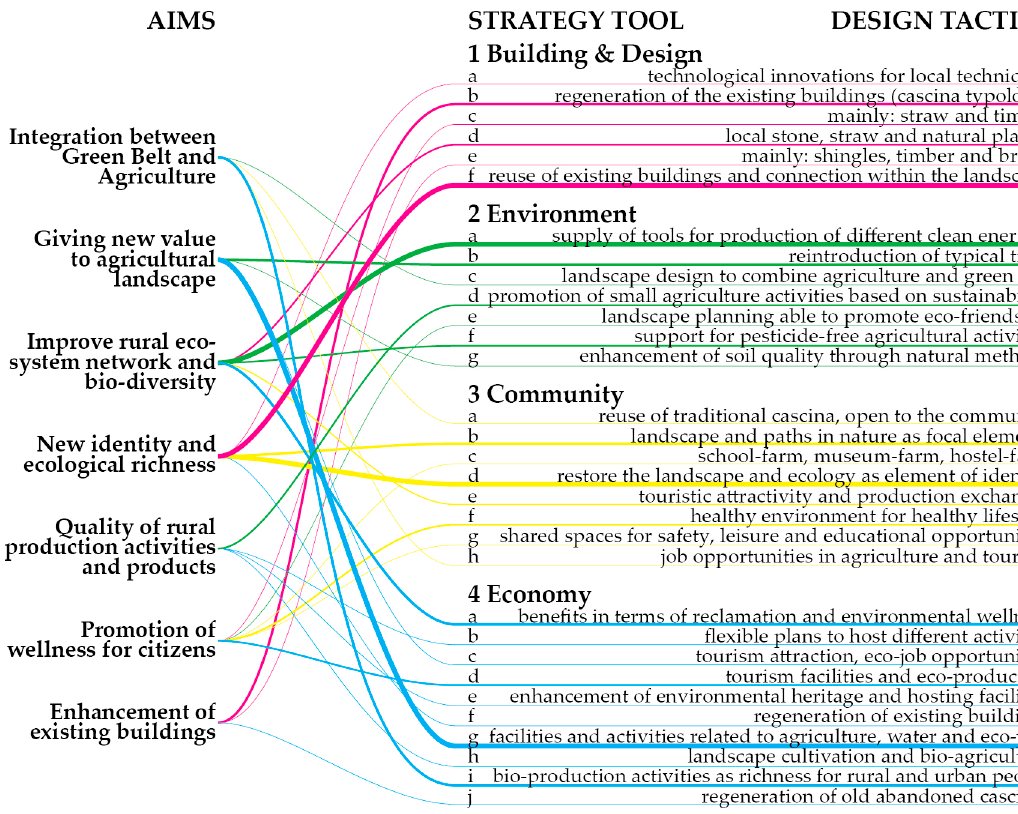
Figure 7. Diagram application of the strategy system tool. Meta-project 2.